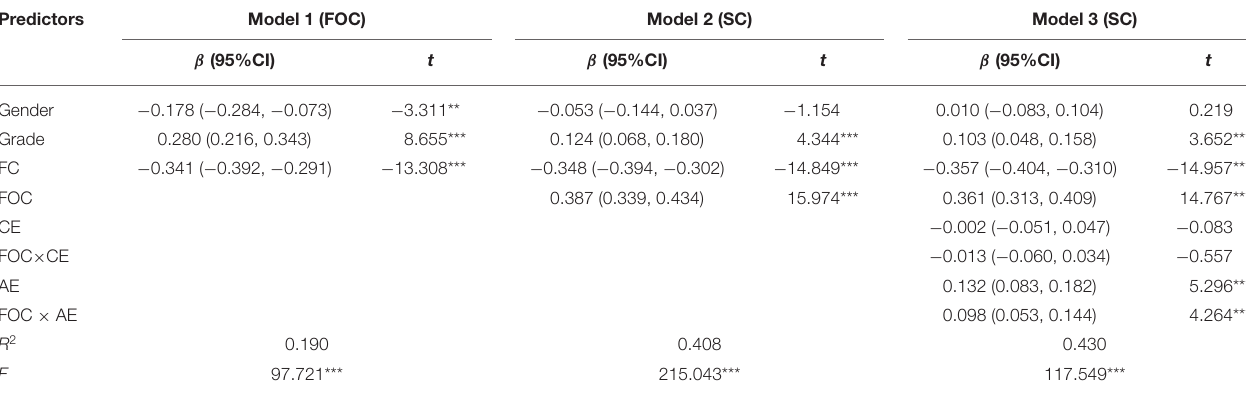
TABLE 2 | Testing the mediation effect and moderated mediation effect of family cohesion on stress consequences.